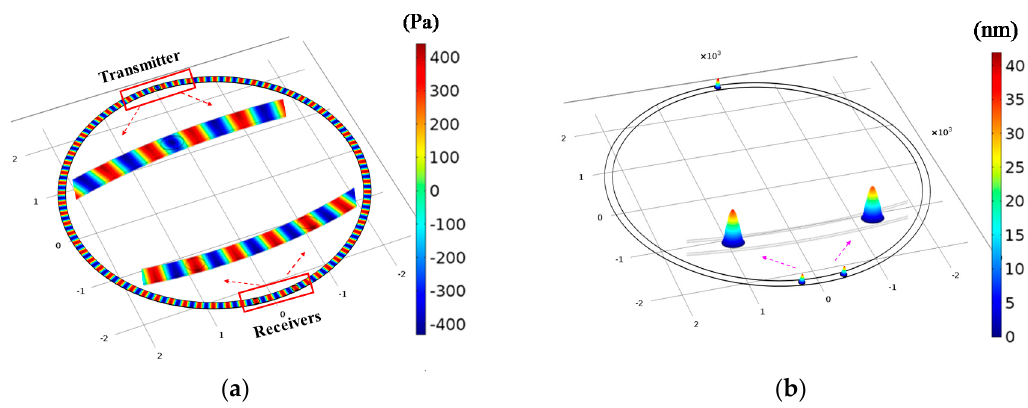
Figure 4. Finite element model (FEM) simulation results. ( a ) Acoustic pressure field distribution inside the air duct ( f 0 = 1.6 MHz). Color bar: Acoustic pressure (Pa). ( b ) Maximum mechanical displacement of the transmitter and receivers. Color bar: Displacement (nm).